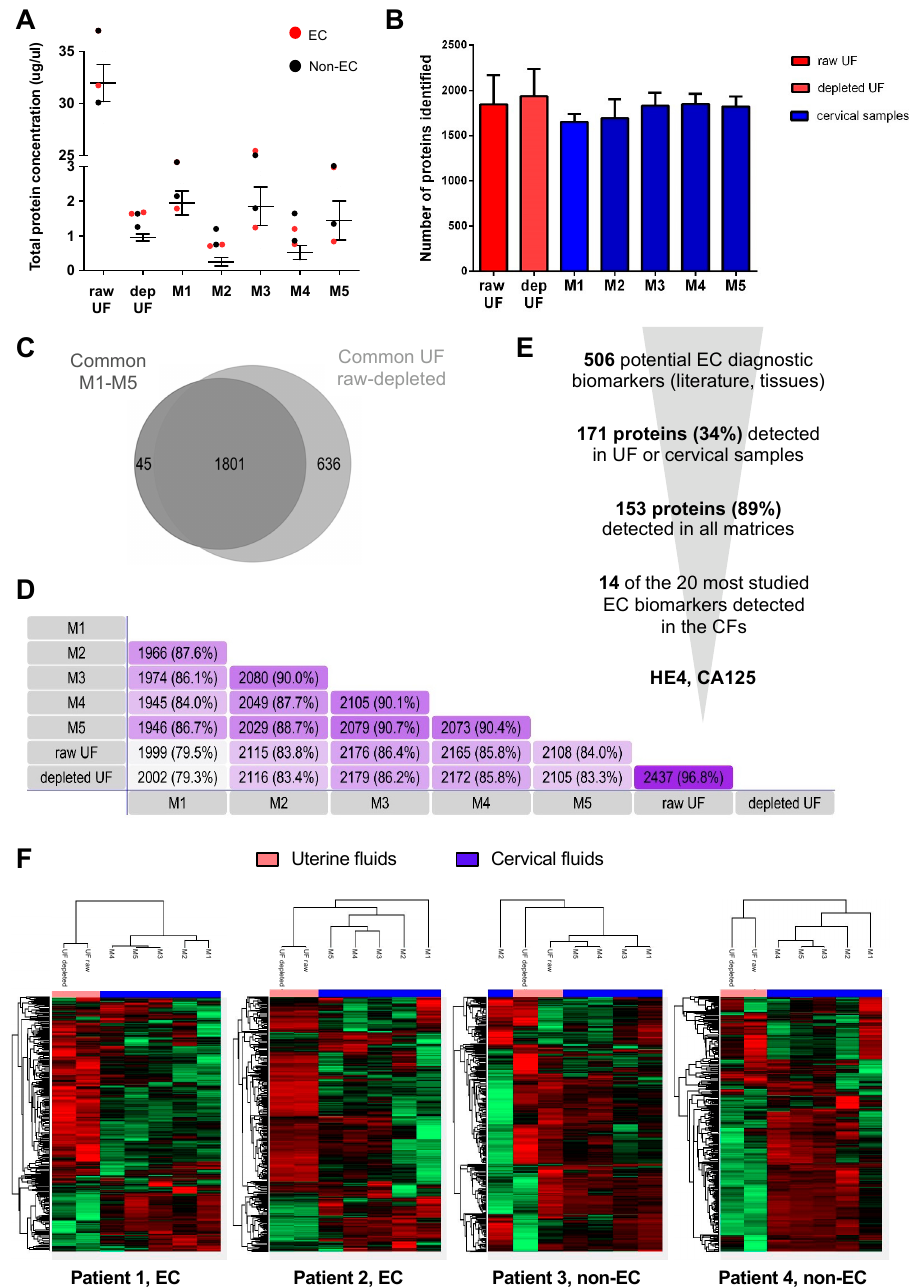
Figure 2. Protein concentration and proteome comparison of uterine and cervical fluids (2 EC, 2 non-EC). ( A ): Total protein concentration ( µ g/ µ L) of raw and depleted uterine fluids and cervical fluids M1–M5. ( B ): Barplot representing the total number of proteins identified by MS in the four patients for each matrix analyzed (in red uterine fluids, and in blue cervical fluids). ( C ): Venn diagram with the common and unique proteins identified in the uterine fluids versus cervical fluids. ( D ): Venn diagram showing the number of proteins in common between the different matrices. ( E ): Detectability of potential EC diagnostic biomarkers in the different matrices. ( F ): Heatmaps showing how the UFs and CFs of the four patients analyzed are clustered based on the protein levels. UF: uterine fluid; dep: